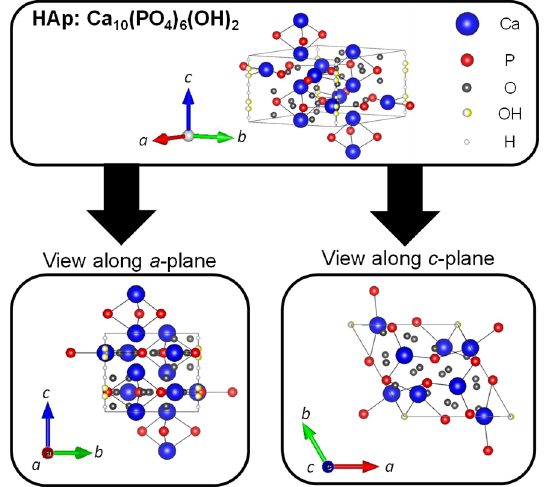
Figure 5. Crystal structures of HAp were drawn using VESTA from a crystallographic information file obtained from the American Mineralogist Crystal Structure Database.